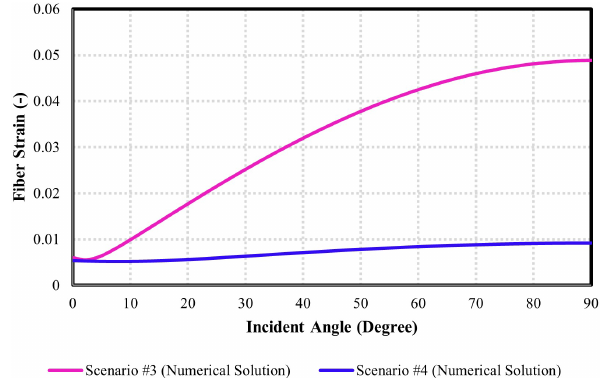
Figure 13. Investigation of the effect of water on the acoustic re- sponse of fibre (comparison between scenarios 5 and 6). The strains are given as absolute values, and the strains for an incident angle below 18 ◦ are tensile.